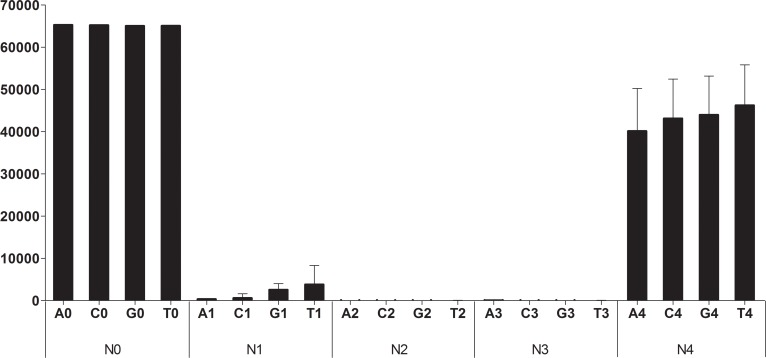
The optimization of ASPE on microarrays for quality controls of allele-specific extension primers using control extension primers.The N0 group of matched control extension primers was made to match the sequences of regions without SNPs in the exon of the MICB gene. Mismatched control extension primers were made to contain artificial mismatches at the 1st, 2nd, 3rd, and 4th bases from the 3′ ends of the N0 extension primers, and were defined as the N1, N2, N3 and N4 groups. Each control primer group consisted of four primers that contained adenine, cytosine, guanine, or thymine (A, C, G, or T) at the 3′ end. MFI, mean fluorescence intensity.